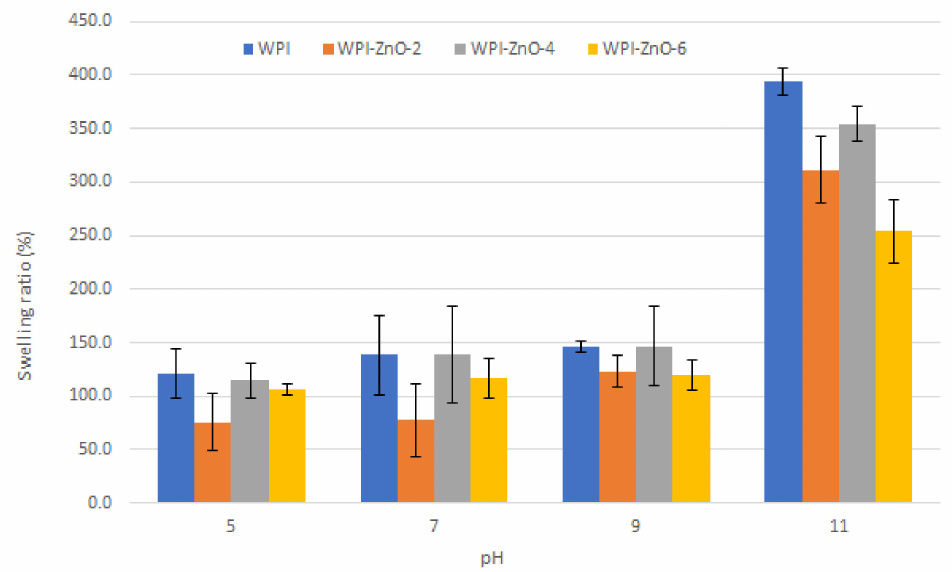
Figure 8. Swelling Ratio versus pH of the WPI film and WPI–ZnO films with different ZnO